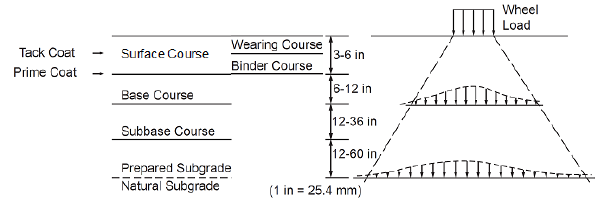
Figure 9: Cross section and stress distribution in a flexible pave- ment: since the loaded area increases with depth, the further down the layer is in the pavement structure, the fewer loads it must carry (from [1]).